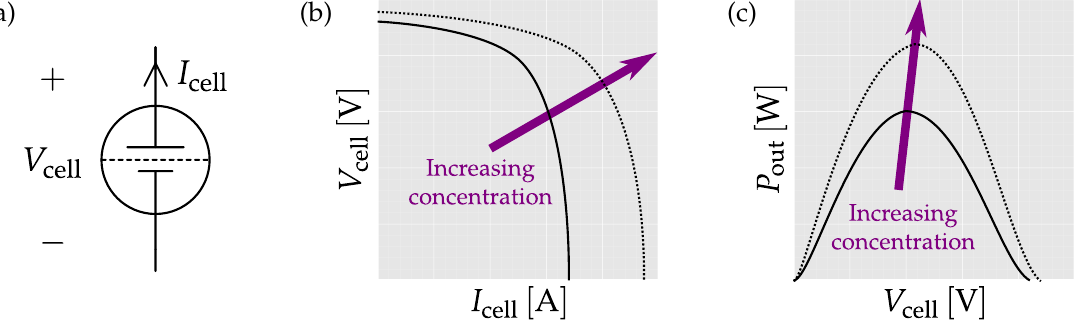
Figure 24. Bio-fuel cell symbol ( a ) and schematic polarization curves: V cell versus I cell ( b ) and output power P out versus V cell ( c